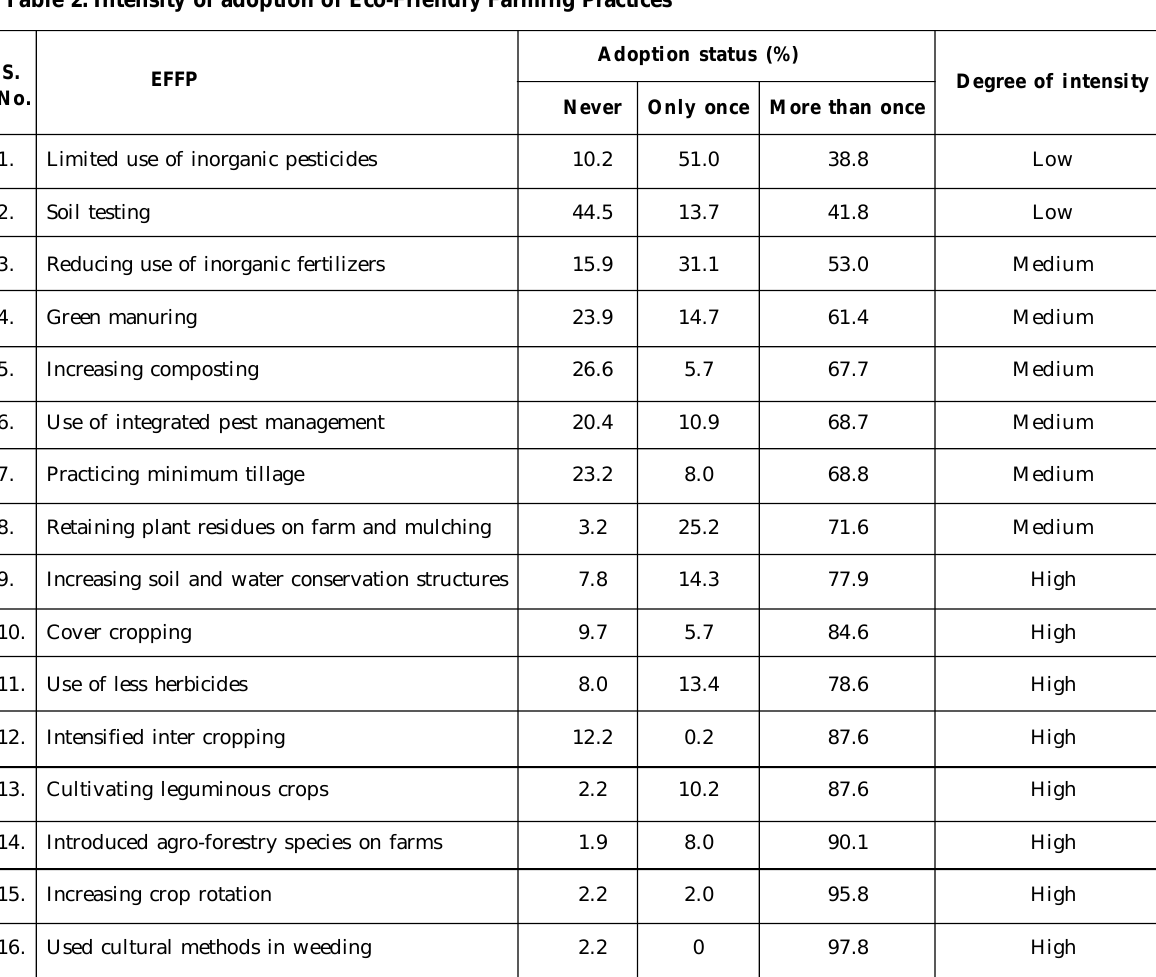
Adoption status (%) Degree of intensity